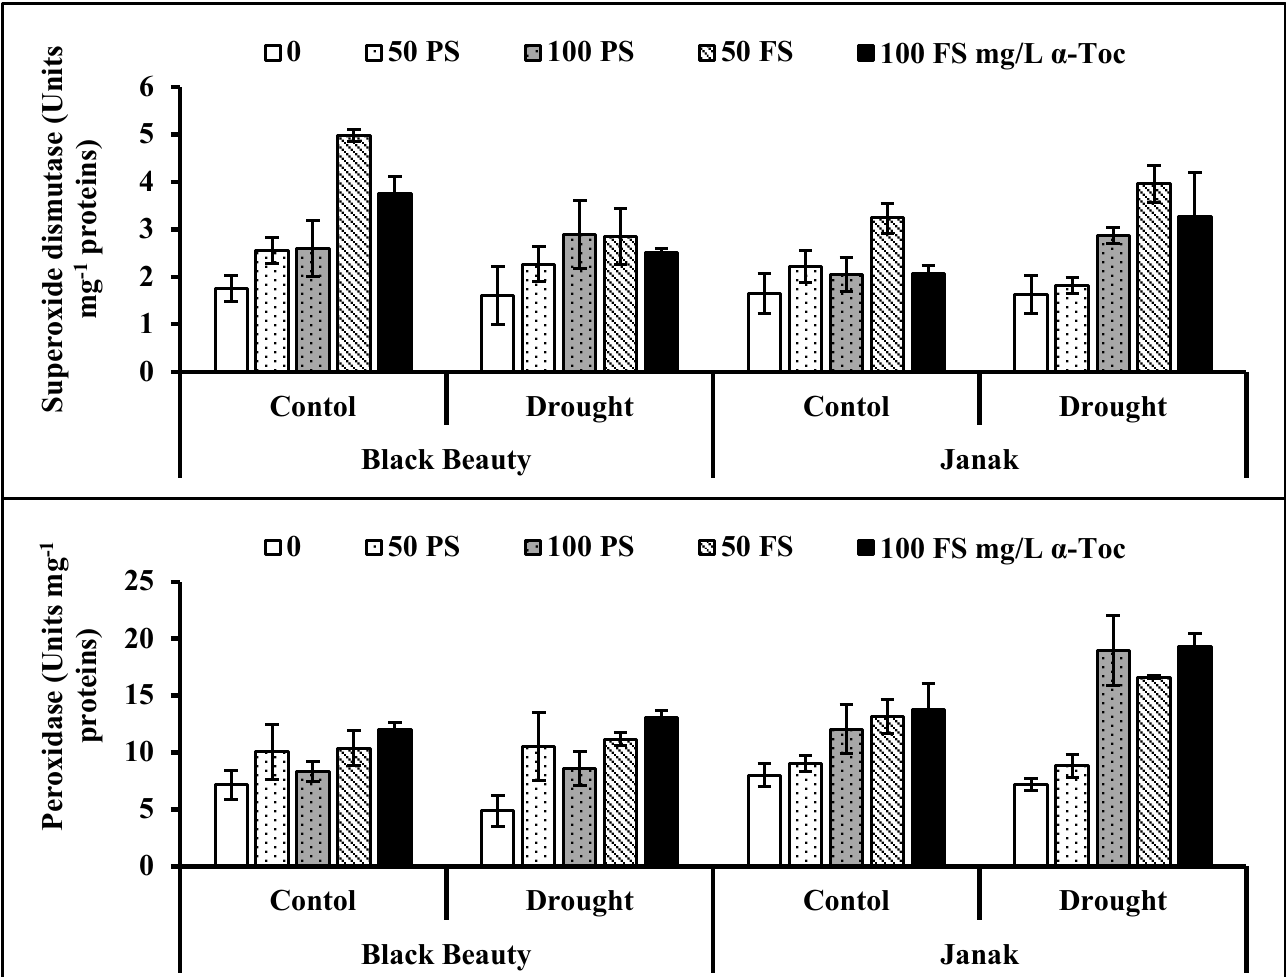
Figure 5. Activities of superoxide dismutase and peroxidase enzymes in two cultivars of eggplant leaves subjected to exogenous TOC (pre-sowing (PS) and foliar spray (FS)) under different water regimes (mean ± S.E.; n = 4).